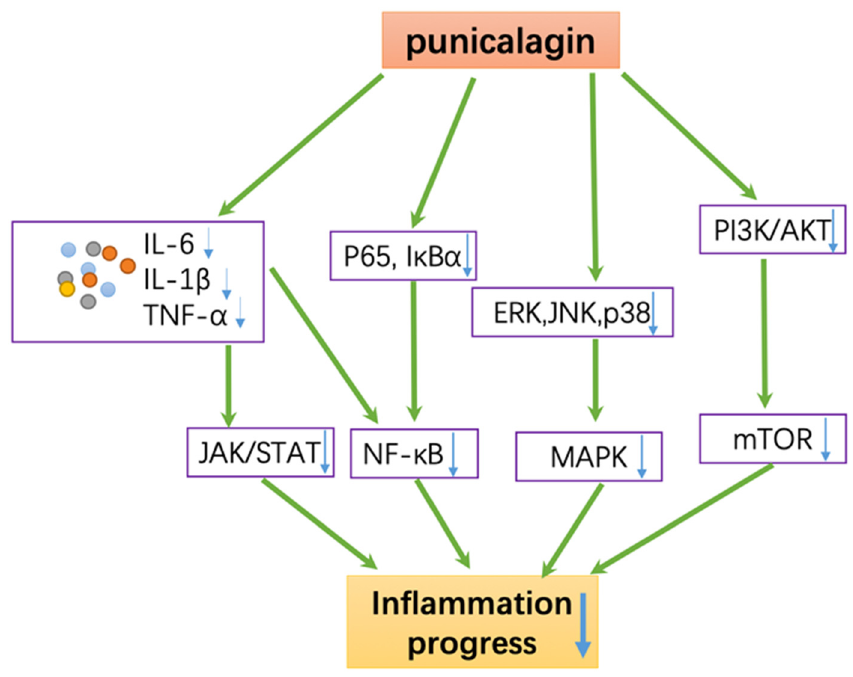
Figure 2. Various molecular targets of punicalagin in inflammation.